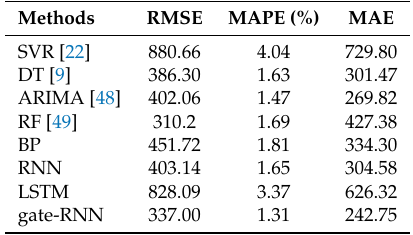
Table 4. Results of eight methods on the 20-min time scale in three months’ test dataset.